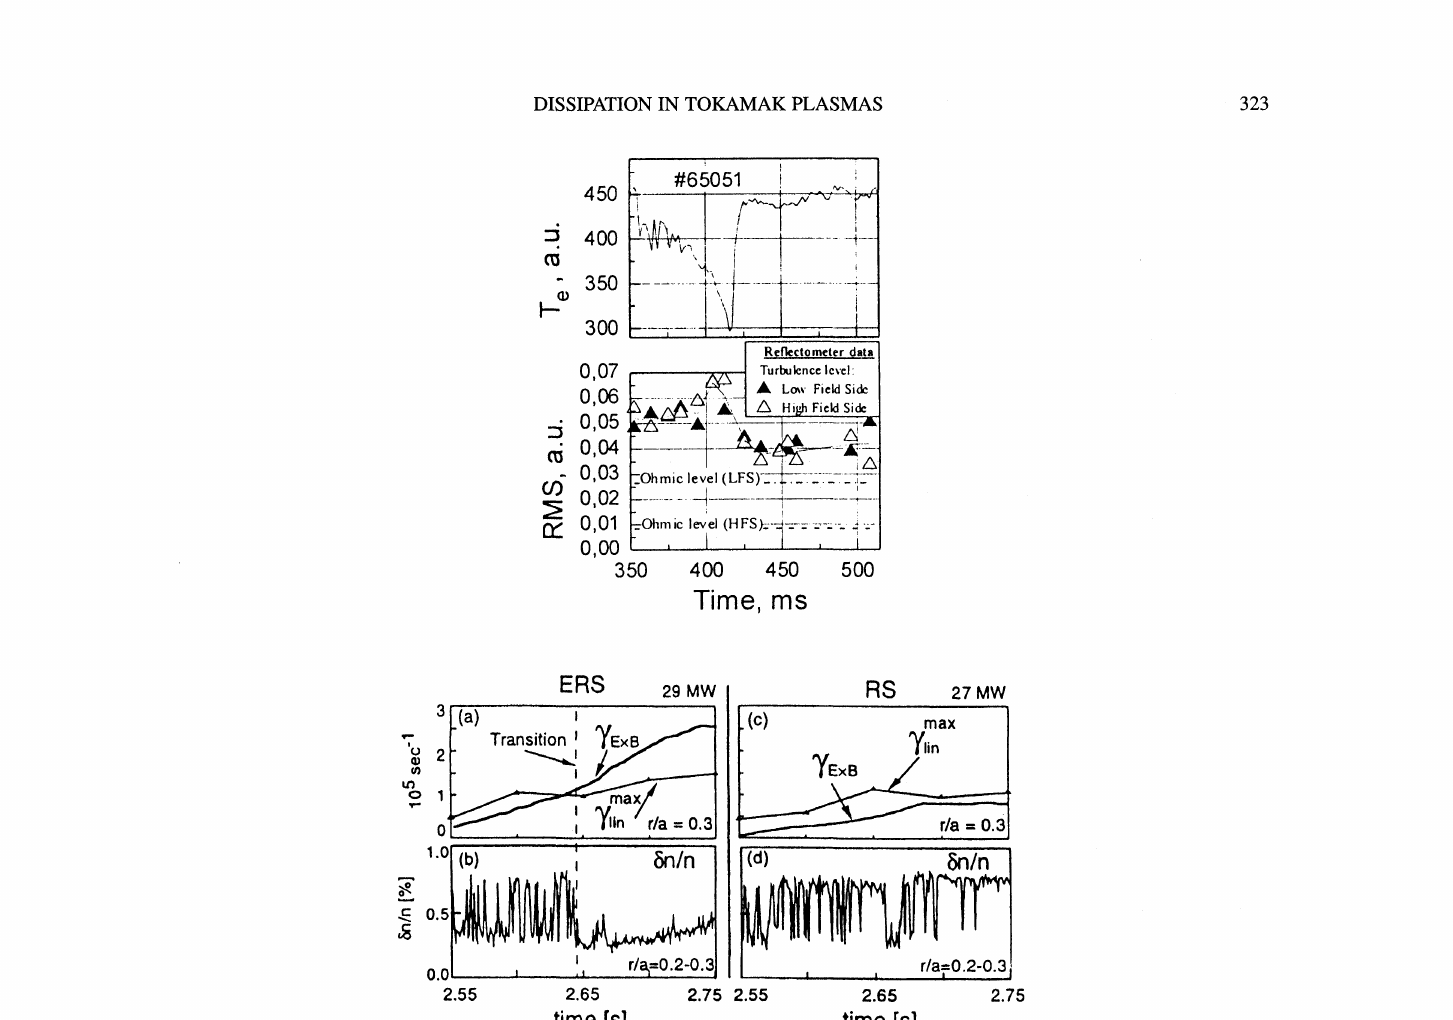
FIGURE 10 (a) T-10 tokamak. The Te and turbulent level temporal evolution during the internal barrier formation. The turbulence was measured both for low and high field side. Dashed lines show the turbulence level for the Ohmic heating stage. (b) TFTR-tokamak. Suppression of the turbulent fluctuations after internal thermal barrier formation, when 7Ex > //ax. The dashed line represents the time of transition (see also Fig.